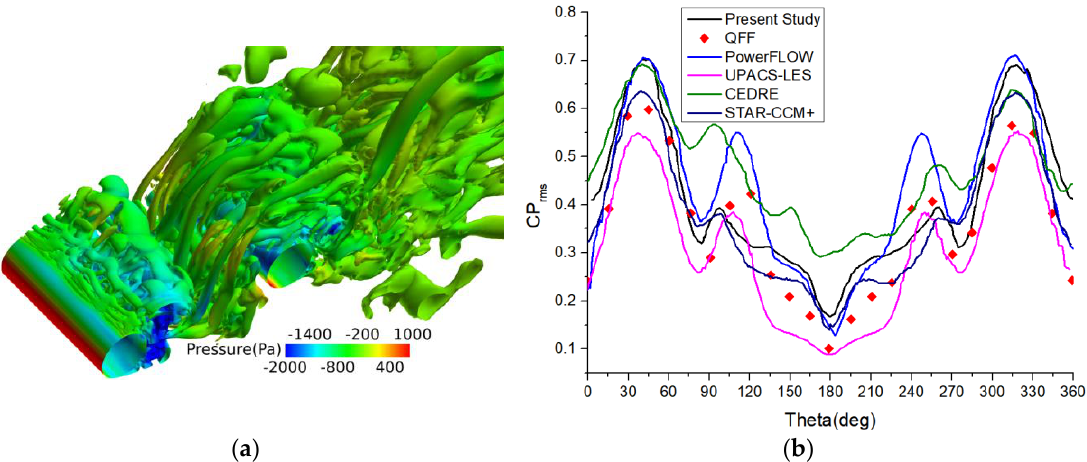
Figure 12. ( a ) Instantaneous iso-surface normalized Q-criterion (Q = 100); and ( b ) the root-mean-square (rms) of the perturbations in Cp.